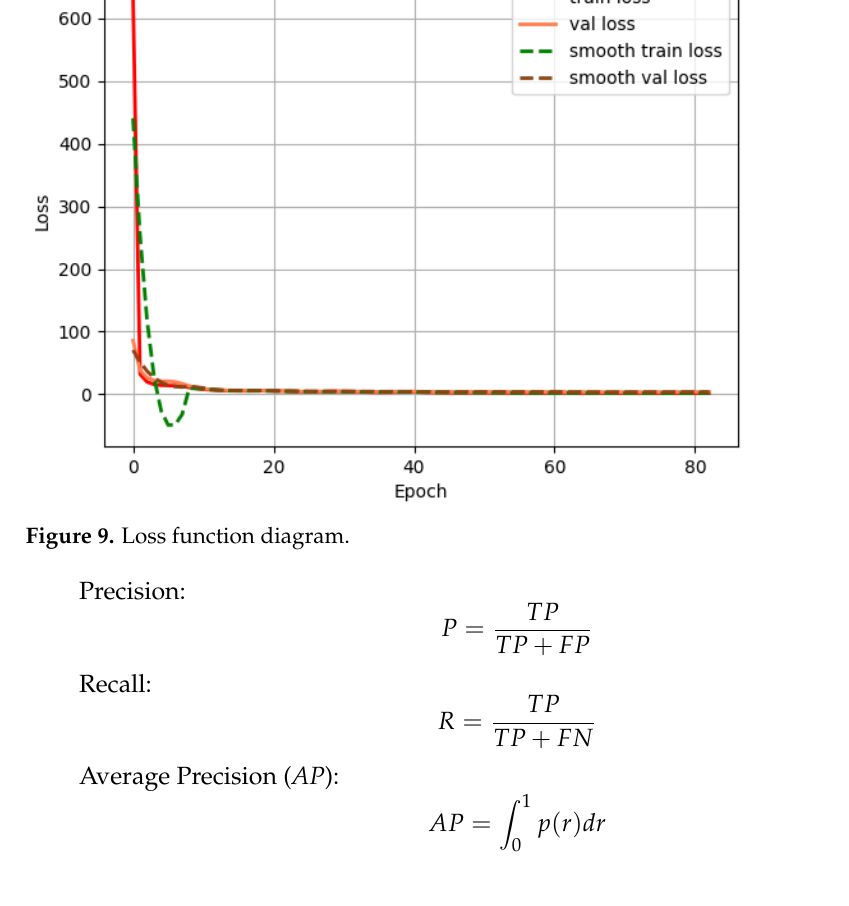
( d ) Figure 10. Graph depicting test results for 400 pictures. ( a ) Precision; ( b ) Recall; ( c ) mAP; ( d ) De- tection-results.